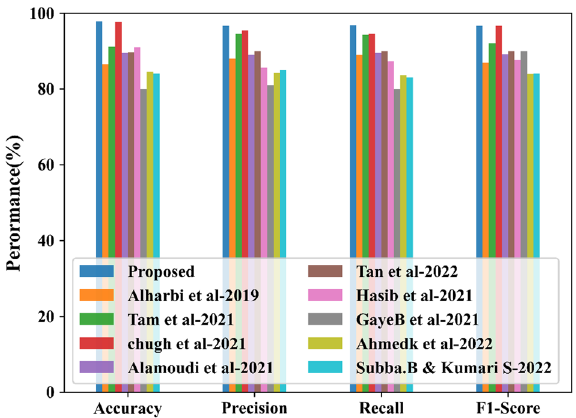
Fig. 8 Performance comparison between proposed and existing methods